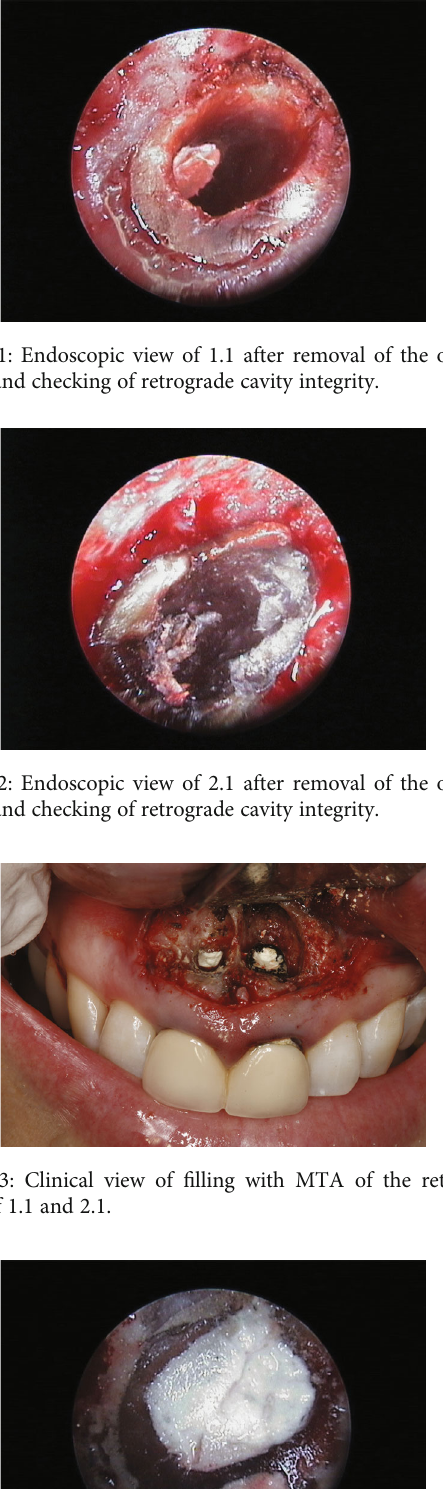
Figure 18: View after 7 days, before suture